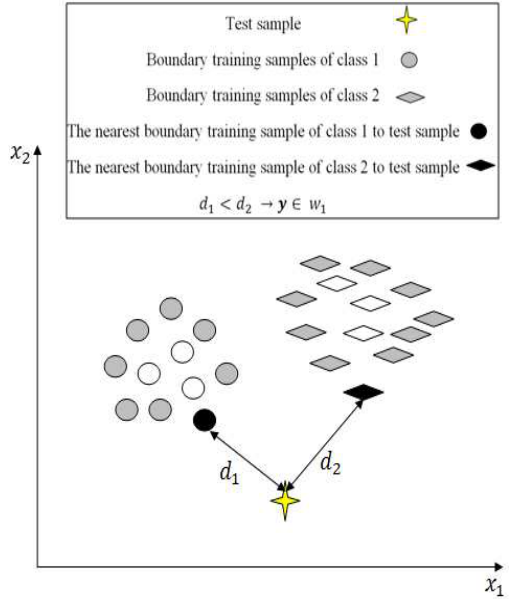
Figure 2. The representation of proposed